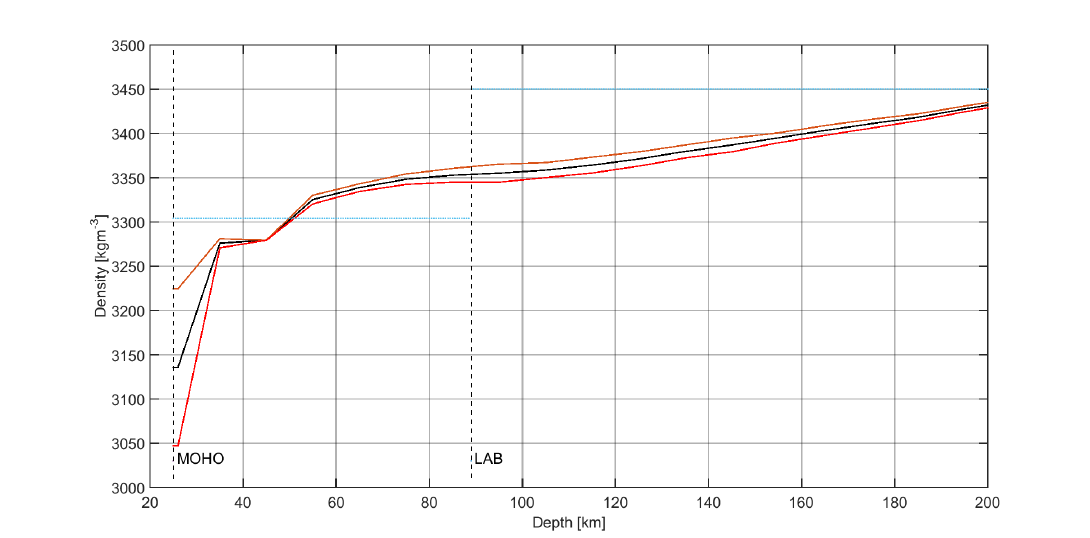
Figure 2. Average density of the considered models (black solid line) and its 1 σ accuracy (red solid lines); mean density in the lithospheric upper mantle and in the asthenosphere from the LithoRef18 model [28] (blue dotted line); Moho and lithospheric asthenosphere boundary (LAB) from LithoRef18 (black dashed lines).